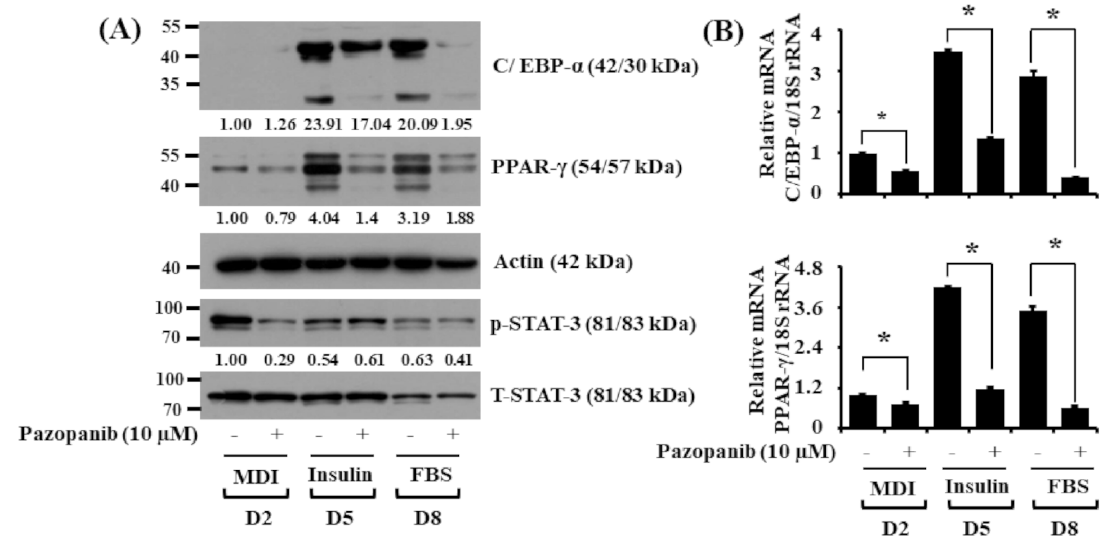
Figure 2. Effects of pazopanib on expression and phosphorylation levels of C/EBP- α , PPAR- γ , and STAT-3 during 3T3-L1 preadipocyte differentiation. ( A ) 3T3-L1 preadipocytes were differentiated with induction medium containing MDI, insulin, and FBS in the absence (control; 0.1% DMSO) or presence of pazopanib (10 µ M), and harvested at day 2 (D2), D5, and D8, respectively. At each time point, whole-cell lysates were prepared and analyzed by immunoblot analysis with respective antibodies. p-STAT-3, phosphorylated STAT-3; T-STAT-3, total STAT-3. ( B ) 3T3-L1 preadipocytes were differentiated with induction medium containing MDI, insulin, and FBS in the absence or presence of pazopanib (10 µ M), and harvested at D2, D5, and D8, respectively. At each time point, total cellular RNA was extracted and analyzed by real-time qPCR with respective primers. mRNA levels of C/EBP- α and PPAR- γ were normalized to those of control 18S rRNA. Data are mean ± SE of three independent experiments, each done in duplication. * p < 0.05 vs.